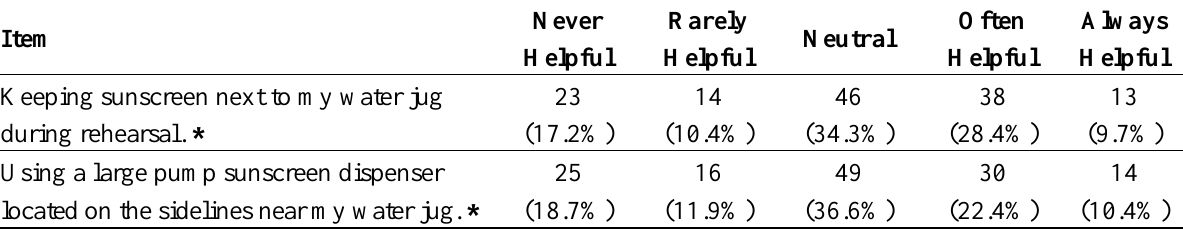
Table 6. Likelihood of Strategy Aiding Sunscreen